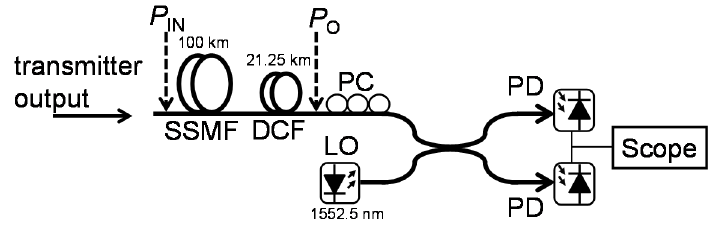
Figure 13. Simulated fiber transmission setup.